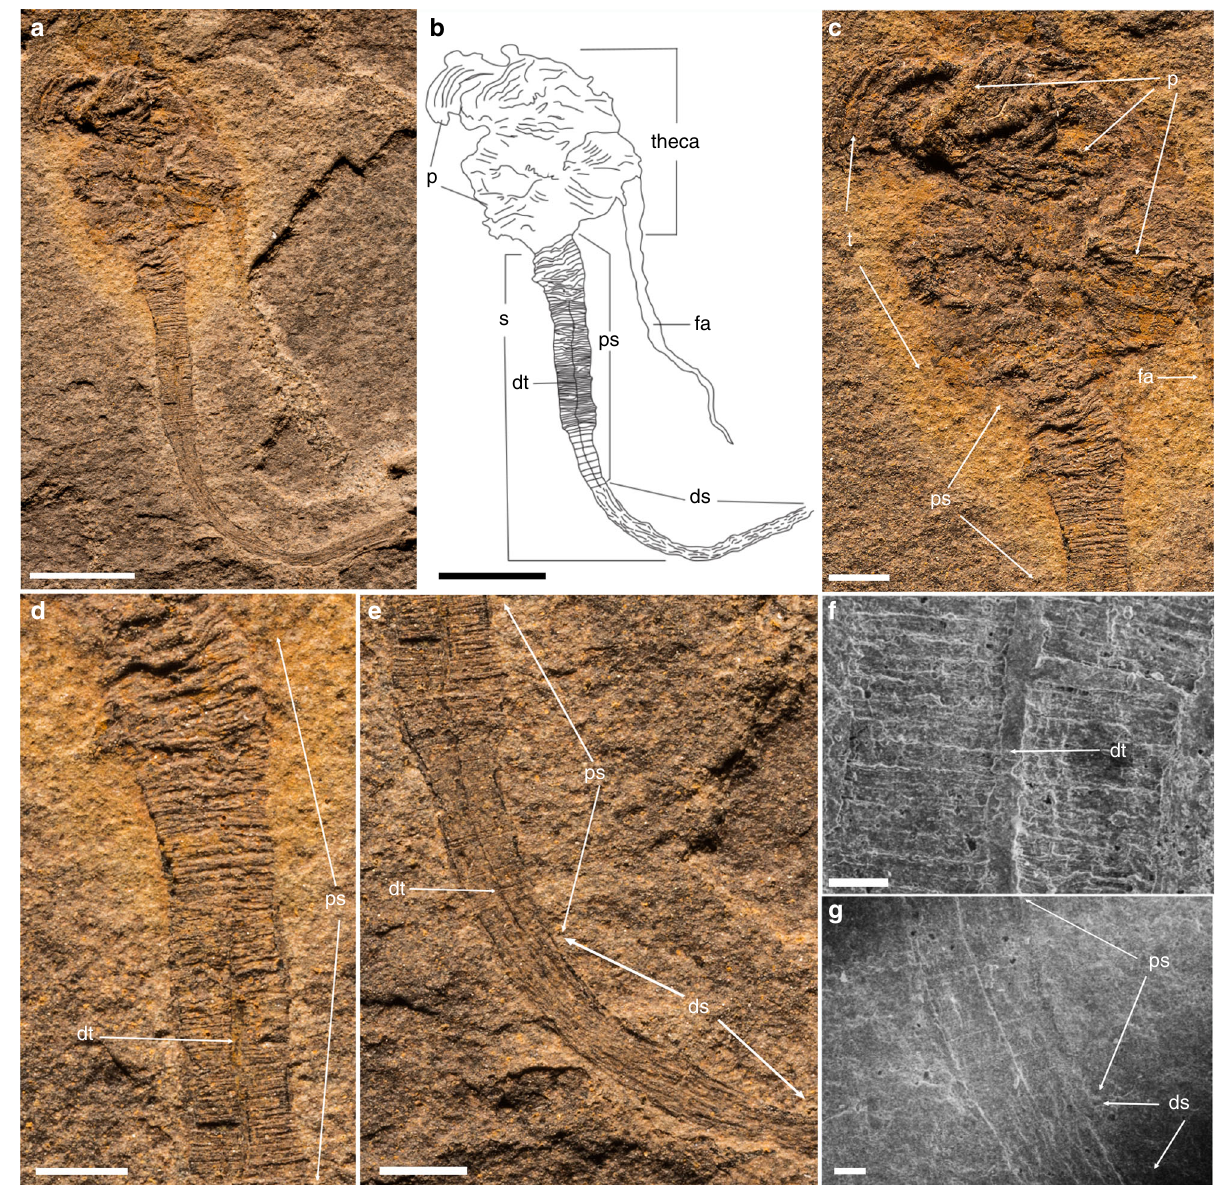
Fig. 1 Yanjiahella biscarpa from the lower Cambrian (Fortunian) Yanjiahe Formation in China. Specimen ELI-HS18. a Specimen with plated theca, a muscular stalk, and a single feeding appendage. b Line drawing of specimen. c Detail of globular theca with plates, a feeding appendage and proximal stalk with distinct transverse ridges. d Detail of proximal stalk showing transverse ridges and a digestive tract. e Details of the stalk showing transition from the transverse ridged proximal stalk to the striated distal stalk. f Scanning electron microscopy (SEM) image of the digestive tract, with transverse ridges visible. g SEM image of the transition from the proximal to distal stalk. Scale bars, 5 mm ( a , b ), 1 mm ( c – e ), and 200 μ m ( f , g ). ds, distal stalk; dt, digestive tract; fa, feeding appendage; p, plate; ps, proximal stalk; s, muscular stalk; t, Fig. 3c). The variable shape of the theca, the strong curvature of mens has hindered any reliable quantitative study. Consequently,